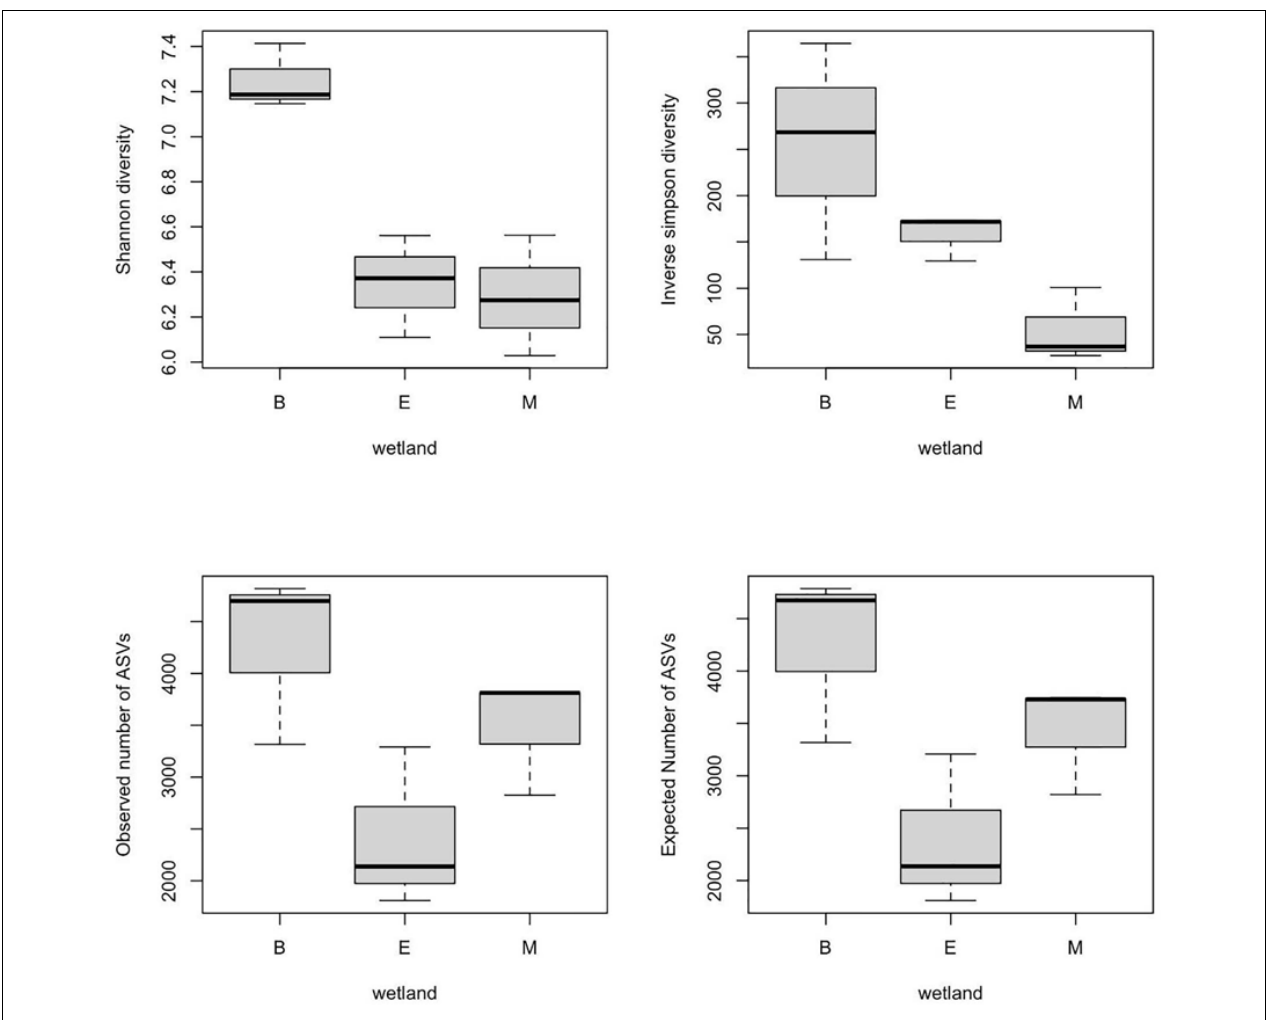
FIGURE 4 | Wetland-wise comparison of different prokaryote ASV α -diversity indices (Shanon and inverse Simpson) and richness (observed ASVs and expected ASVs). The data are pooled over three primers for each wetland. The abbreviations used are as follows: B, Bhomra; E, EKW; M, Malencho; ASV, amplicon sequence variant; EKW, East Kolkata